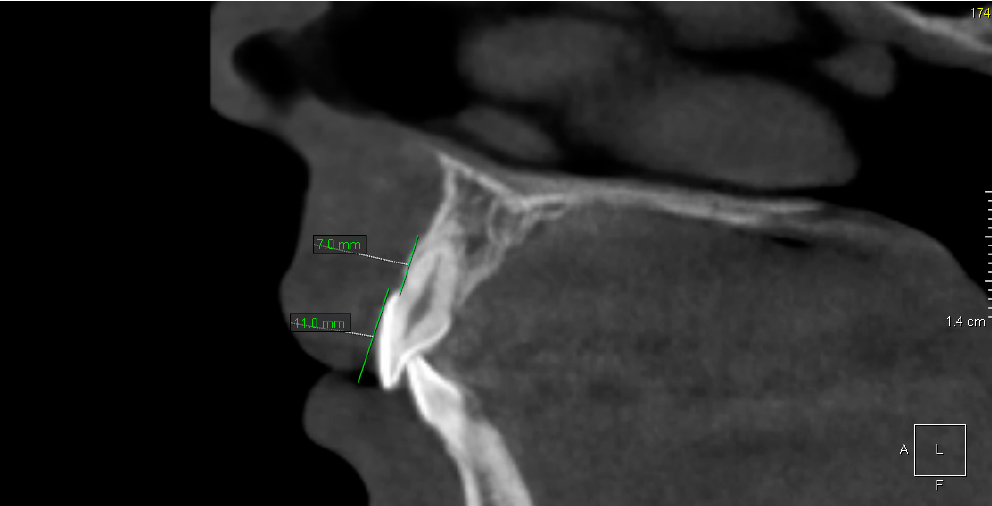
Figure 2. Patient 1. Rhizomicria of upper right central incisor (11)—Sagittal reconstruction from CBCT.